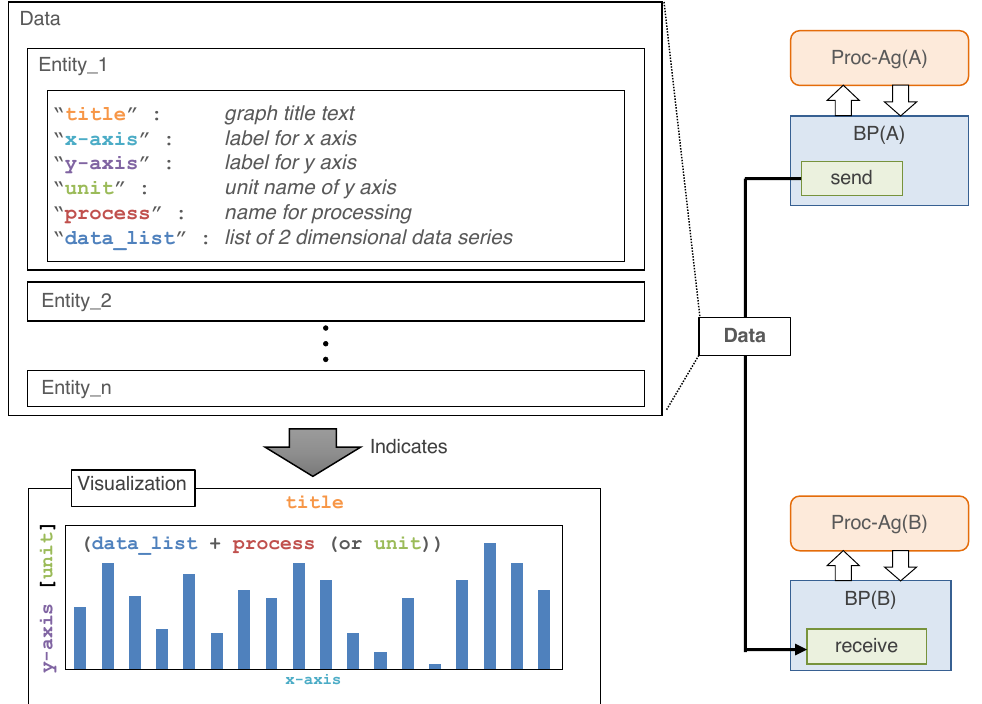
Figure 6. Structure of data exchanged between the base processes. Data are delivered as a piece of variables with metadata in JSON